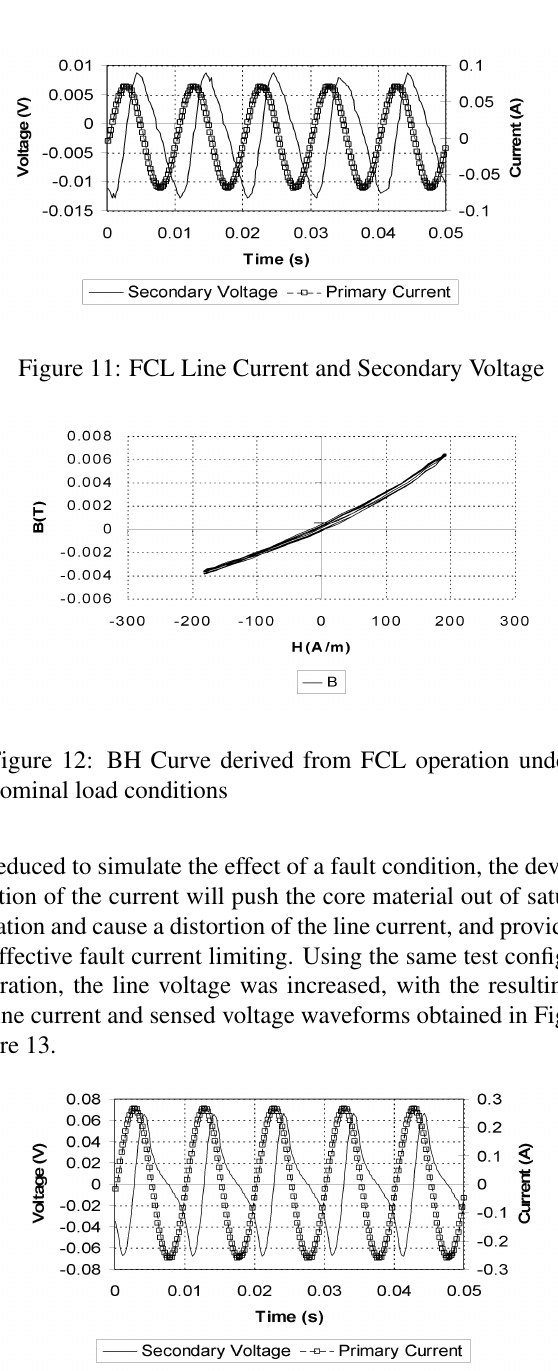
Figure 13: FCL Sensed Line Current and Secondary Moni- tor Voltage Waveforms